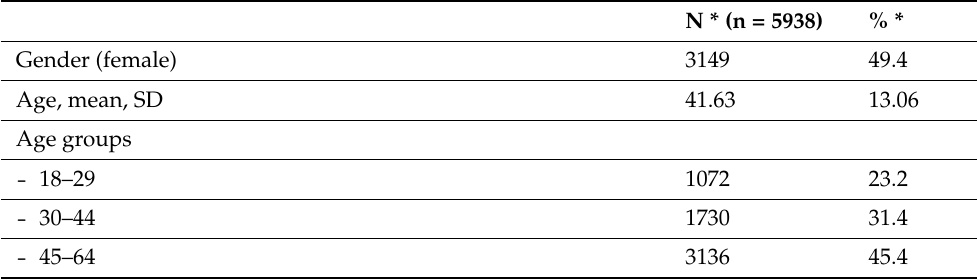
Table 1. DEGS1 participants: socio-demographic characteristics and prevalence of violence experi- ences (weighted